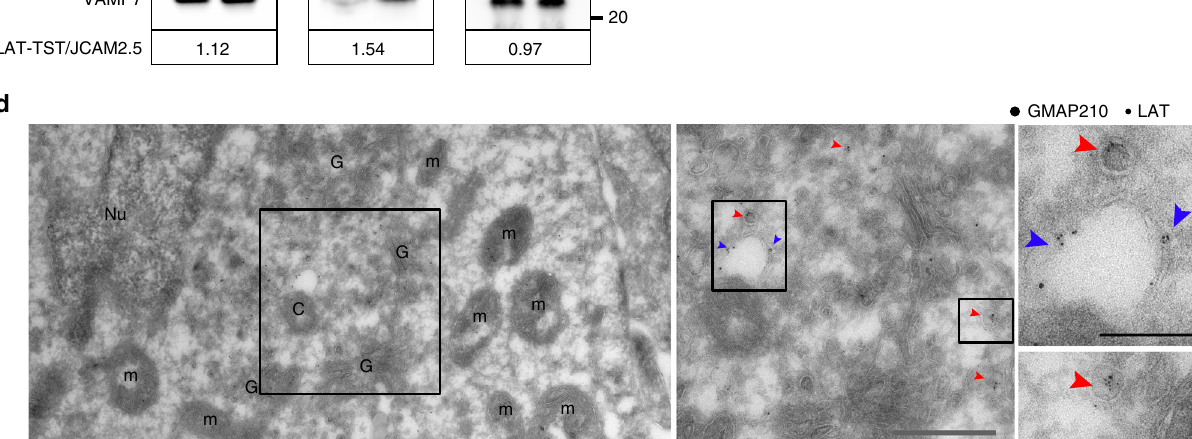
LATM.W. Fig. 1 GMAP210 is present in membranes puri fi ed from T lymphocytes and containing LAT. a JCAM2.5 LAT-de fi cient T-cells expressing a chimeric mouse LAT coupled to two Strep-Tag (LAT-TST) were mechanically disrupted. The membrane fraction was then submitted to a fl oatation gradient on iodixanol. After ultracentrifugation, 10 fractions from top to bottom were collected and submitted to SDS – PAGE and Western blot analysis. b Transmission electron microscopy performed on membranes from fraction 3 showing an immunogold staining for LAT (6 nm gold particles) and GMAP210 (10 nm gold particles). Scale bar: 50 nm. c Fraction 3 prepared from JCAM2.5 (JCAM) or JCAM2.5 expressing LAT-TST (LAT-TST) were prepared as in a . They were mixed with Strep-Tactin Sepharose and submitted to SDS – PAGE and Western blot analysis. The presence of GMAP210, GM130, LAT-TST, and VAMP7 in: the fraction 3 before precipitation; the Strep-Tactin precipitates (StepTactin); and the total lysates obtained in the presence of detergent (Lysate), are shown. Ratios showing the relative expression of the different proteins in JCAM2.5 expressing LAT-TST as compared to the expression in JCAM2.5 are presented under each WB (LAT-TST/JCAM). d Transmission electron microscopy images of fi xed Jurkat cells overexpressing LAT showing an immunogold staining for LAT (6 nm gold particles) and GMAP210 (10 nm gold particles); c centriole; g Golgi apparatus. Red arrows show small vesicles presenting both LAT and GMAP210 staining, blue arrows show a bigger vesicle “ capping ” a centriole. White Scale bar: 1 μ m, gray scale bar: 500 nm, black scale bar: 200 nm. Data represent three independent experiments ( a ) and one experiment ( b – d